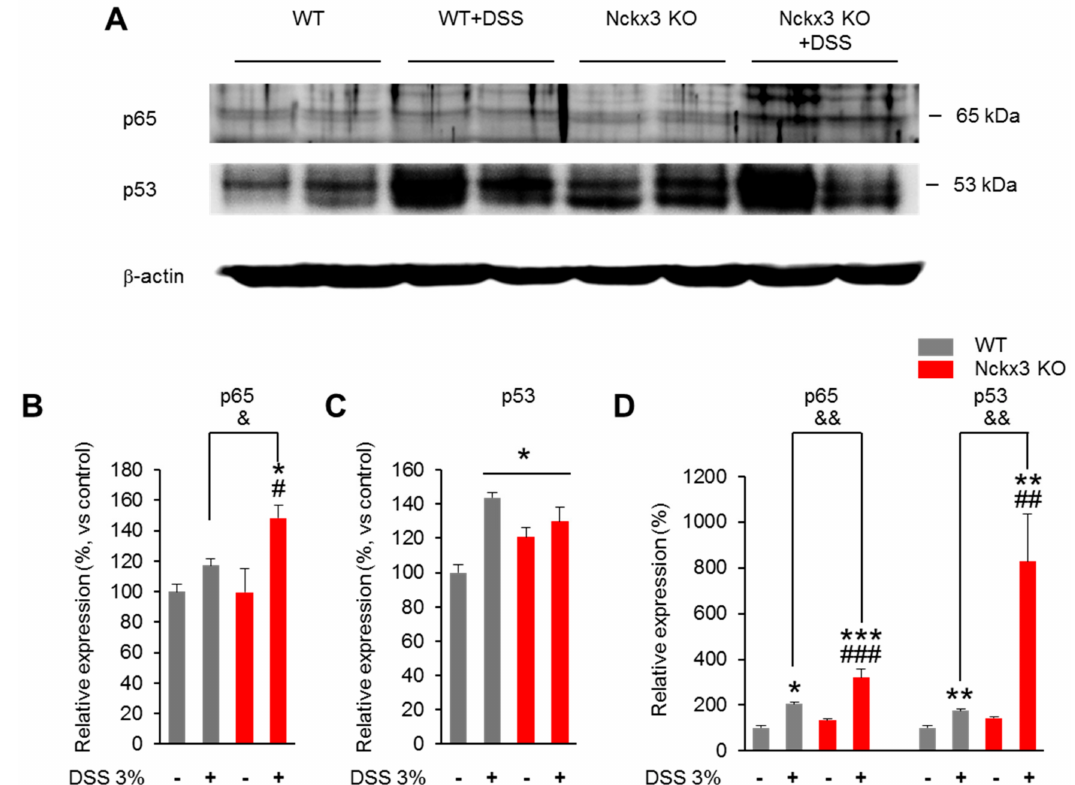
Figure 6. Nckx3 regulates NF- κ B activation by targeting p53. ( A ) NF- κ B p65 and p53 and GAPDH protein expression levels in the colon of WT and Nckx3 KO mice were detected by Western blotting. ( B , C ) Quantification of ( A ). The protein level of p65 was increased in the WT + DSS compared to the WT group, but not significantly. However, the Nckx3 KO +DSS groups showed a markedly higher protein level of p65 than in the WT, WT + DSS and Nckx3 KO groups. In addition, the WT, WT + DSS and Nckx3 KO groups showed higher protein levels of p53 than the WT group (n = 10 per group). ( D ) RT-qPCR analysis NF- κ B p65 and p53 mRNA expression levels in colon of WT and Nckx3 KO mice (n = 10 per genotype). Data represent the mean ± SEM. Statistical significance was determined by one-way ANOVA with Bonferroni correction. * p < 0.05 vs. WT, ** p < 0.01 vs. WT, *** p < 0.001 vs. WT, # p < 0.05 Nckx3 KO + DSS vs. Nckx3